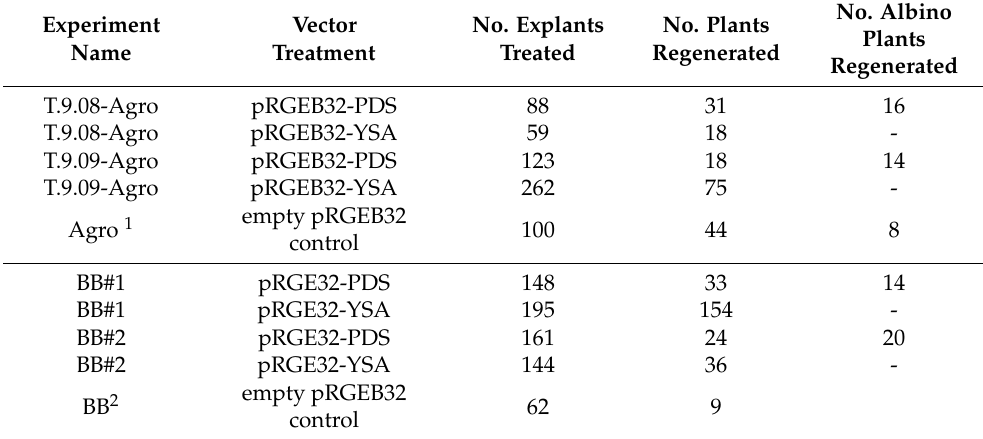
Table 2. Numbers of transformed explants, regenerated plants, and albino plants regenerated.